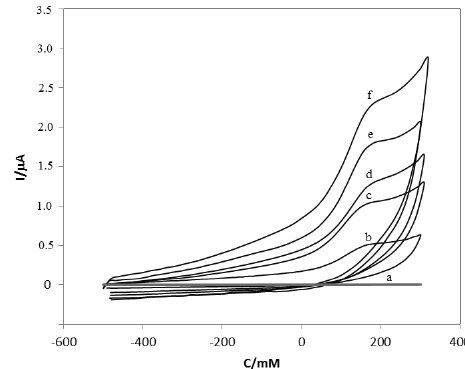
Figure 5. Cyclic voltammogram of H 0.05M pH7.0 and scan rate 50mV/s. Concentration of H